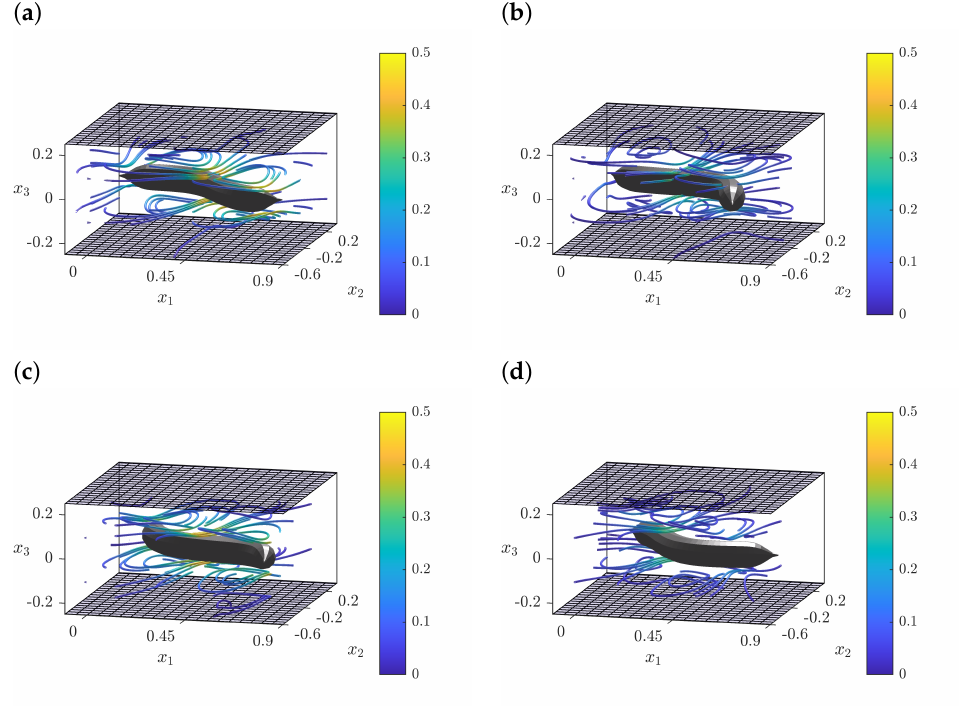
Figure 11. Undulating nonslender swimmer between solid boundaries, full boundary integral calculation, with maximum radius a 0 = 0.06. ( a – d ) instantaneous streamlines in the fluid at four approximately equally spaced intervals during the beat